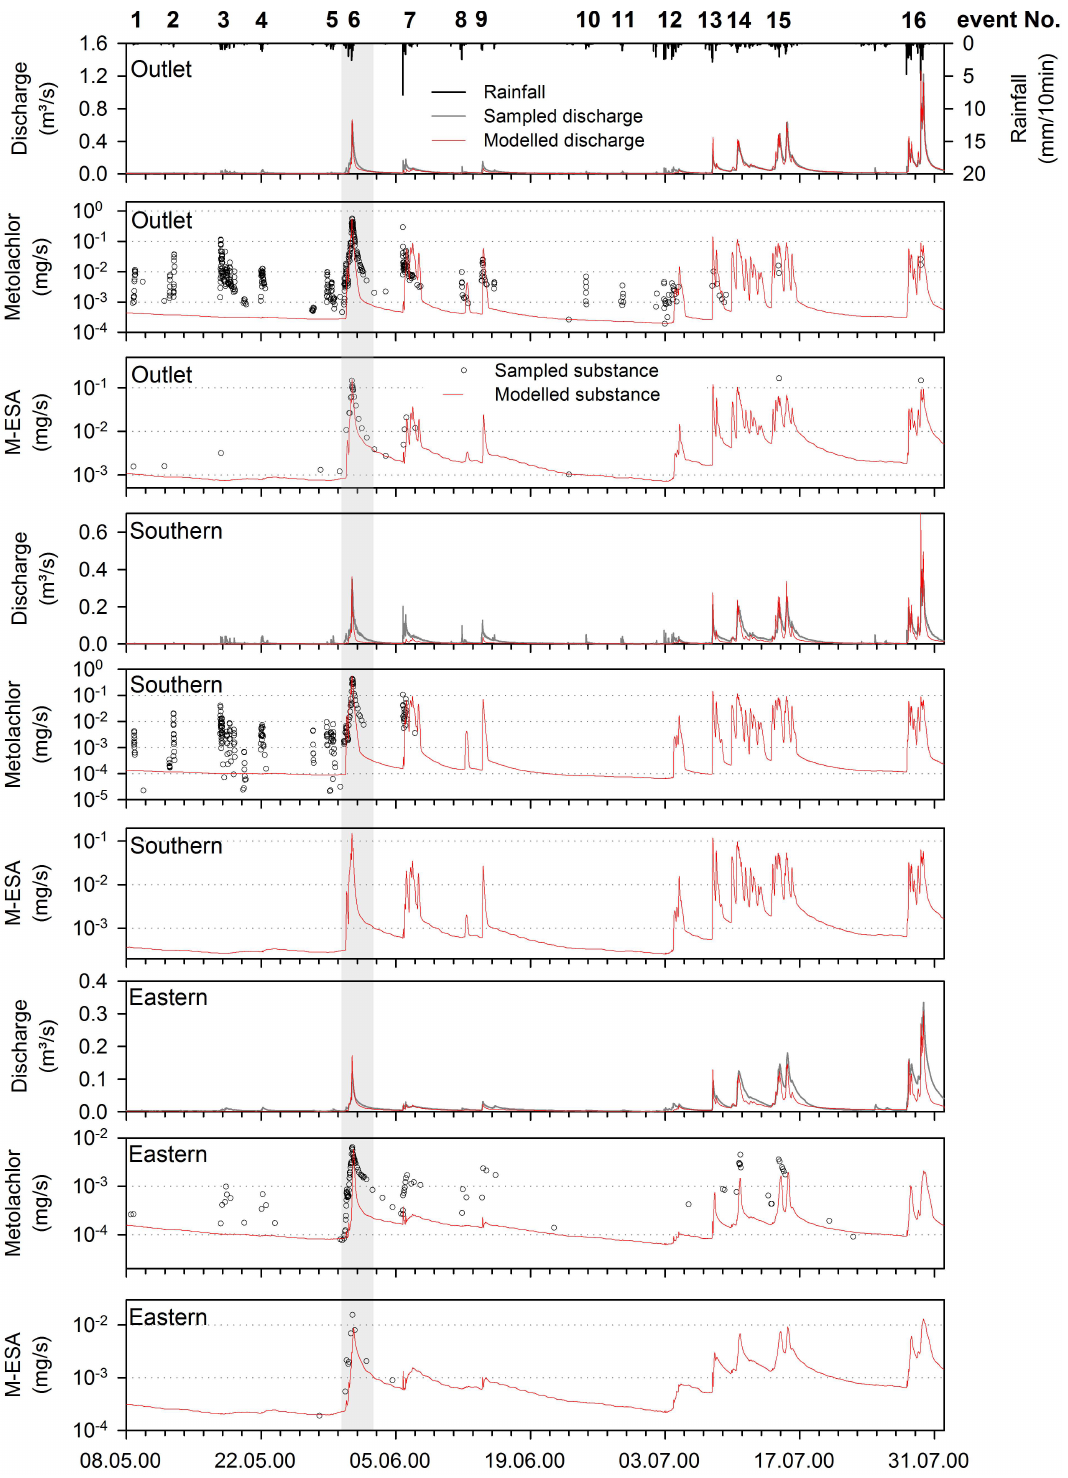
Fig. 2. Modelled and observed discharge, Metolachlor and M-ESA fluxes at all three sampling stations. The main loss event (No. 6) is shaded.